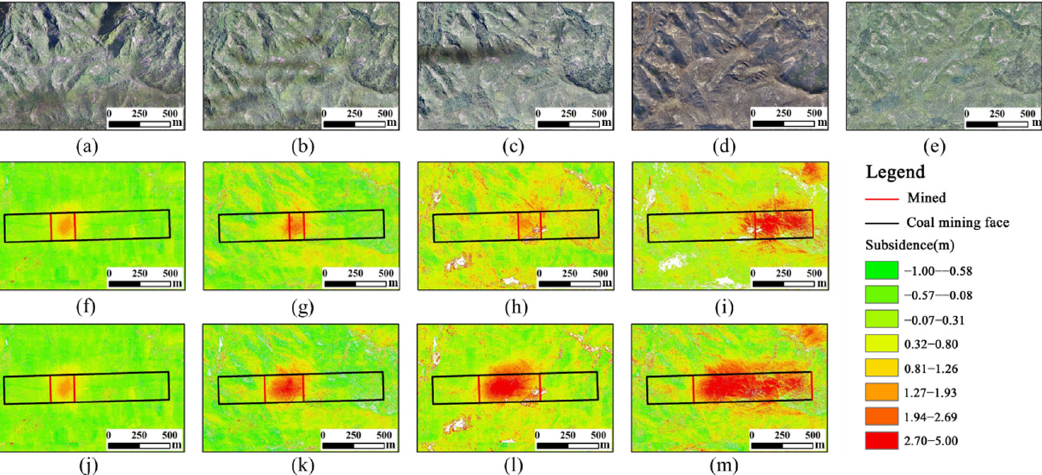
Figure 5. Development process for the dynamic subsidence basin at the working face: ( a ) 1 − 06.14; ( b ) 2 − 07.20; ( c ) 3 − 09.07; ( d ) 4 − 11.15; ( e ) 5 − 07.31; ( f ) 1 − 2; ( g ) 2 − 3; ( h ) 3 − 4; ( i ) 4 − 5; ( j ) 1 − 2; ( k ) 1 − 3; ( l ) 1 − 4; and ( m ) 1 − 5.